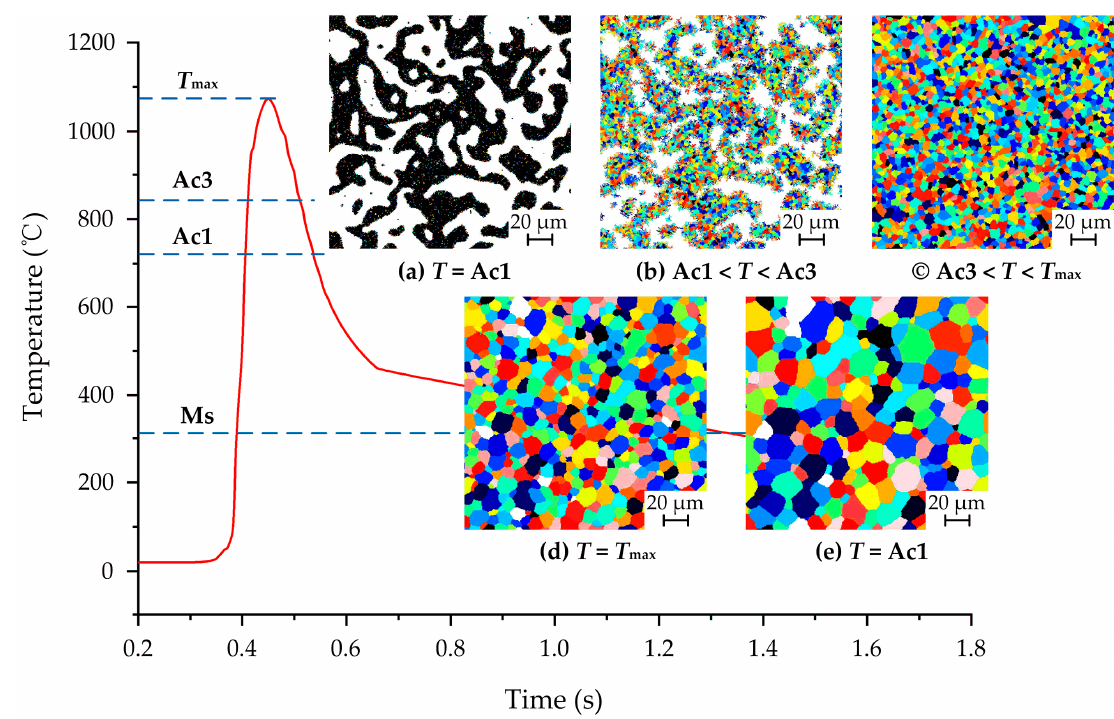
Figure 7. Austenite transformation on workpiece surface at different heating temperatures: ( a ) T = Ac1; ( b ) Ac1 < T < Ac3; ( c ) Ac3 < T < T max ; ( d ) T = T max ; ( e ) T = Ac1.